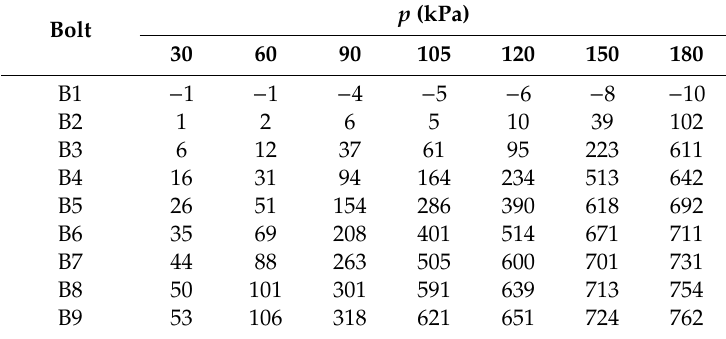
Table 5. The stress of bolts at each loading step in E6 (unit: